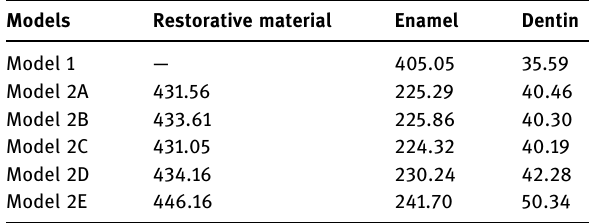
Table 2: Maximum Von Mises stress values ( MPa ) in models